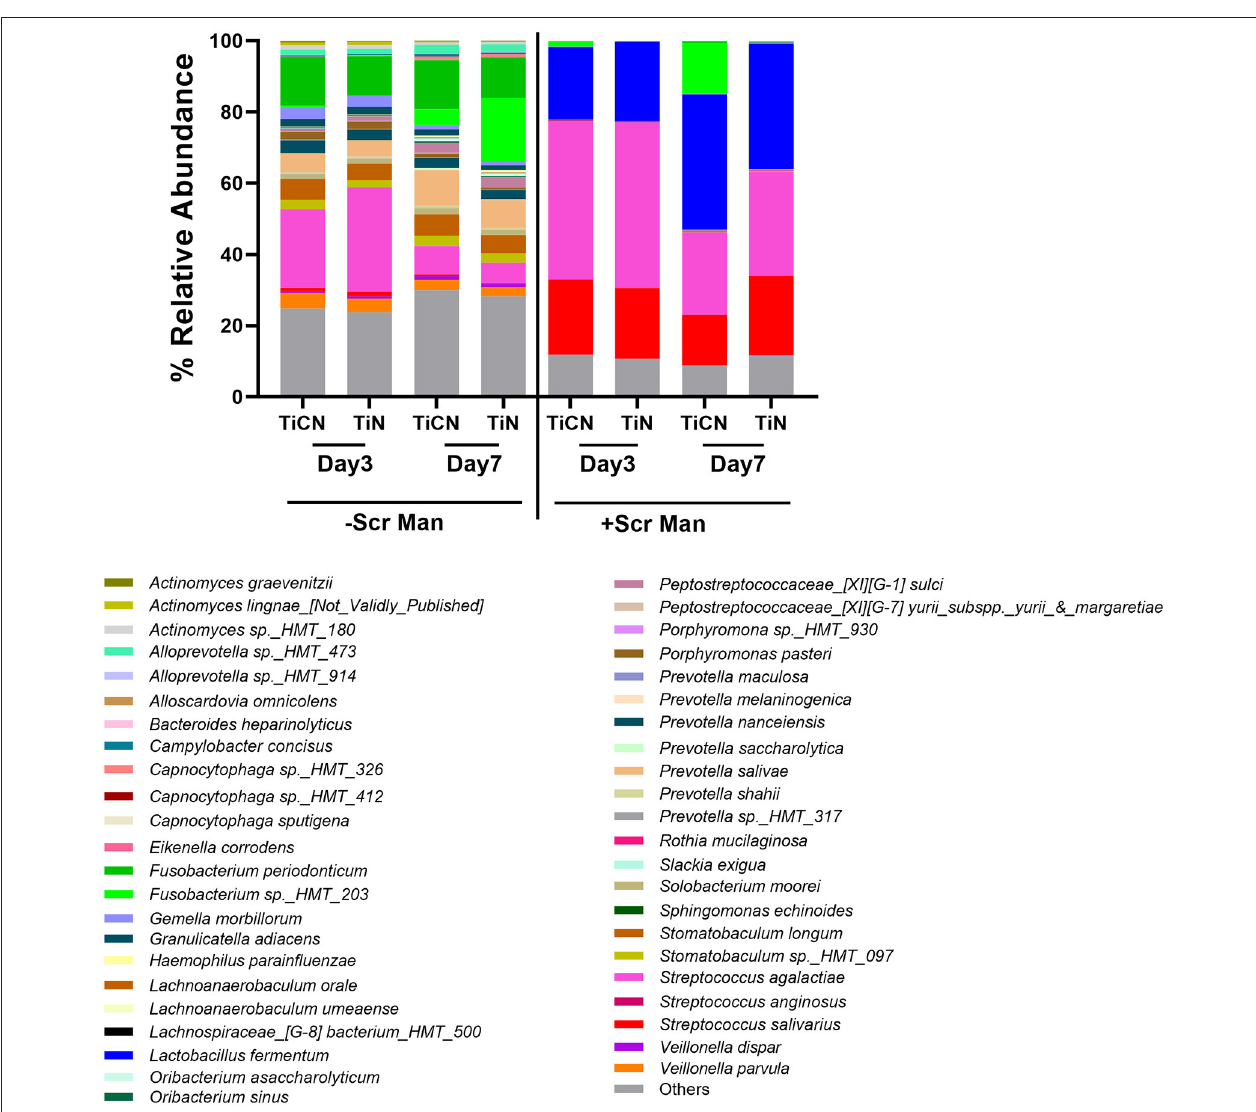
FIGURE 6 | Species level microbial composition determination of TiCN and TiN surface-associated oral biofilms via 16S rRNA gene sequencing. Bar plots represent the relative abundance of species present in the oral biofilm communities formed on TiCN- and TiN-coated discs on day3 or day7 after growth in the absence or presence or of Scr and